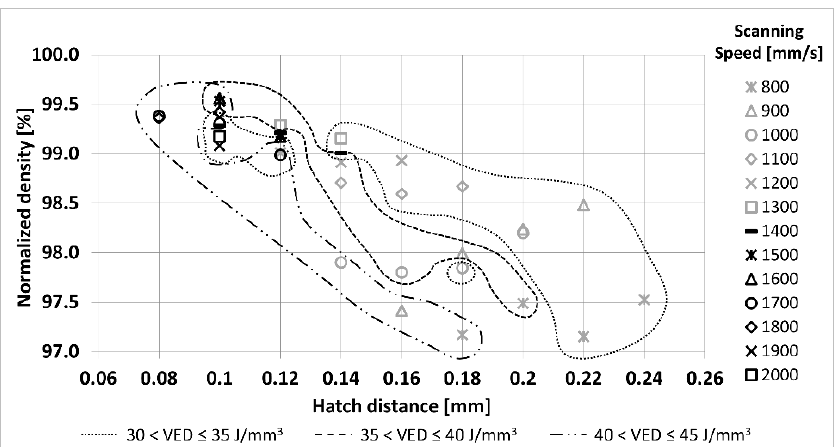
Figure 4. Relative densities measured with Archimedes’ method in relation to the different parameters applied in step 1 of the analysis.